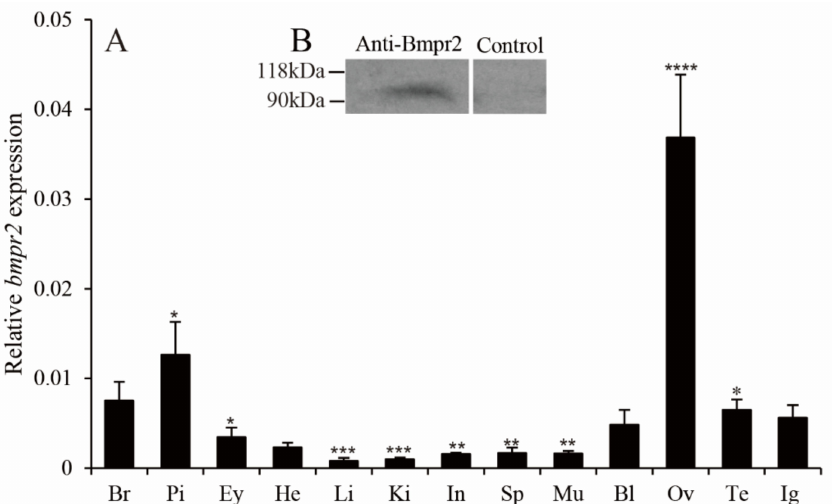
Figure 3. Expression of bmpr2 in different tissues of ricefield eel, Monopterus albus . ( A ), Relative mRNA levels of bmpr2 in tissues of ricefield eels were analyzed using RT-qPCR. ( B ), Bmpr2 immunoreactivity in the ovaries was evaluated using Western blot analysis. Anti-Bmpr2, primary antibody; Control, negative control; Bl, blood; Br, brain; Ey, eyes; He, heart; Ig, intersex gonads; In, intestines; Ki, kidneys; Li, liver; Mu, muscle; Ov, ovaries; Pi, pituitary; Sp, spleen; Te, testes. Results are expressed as means ± SEMs ( n = 5). *, **, *** and **** are the significant differences of Duncan’s multiple comparisons, representing * p < 0.05, ** p < 0.01, *** p < 0.001 and **** p < 0.0001, respectively.